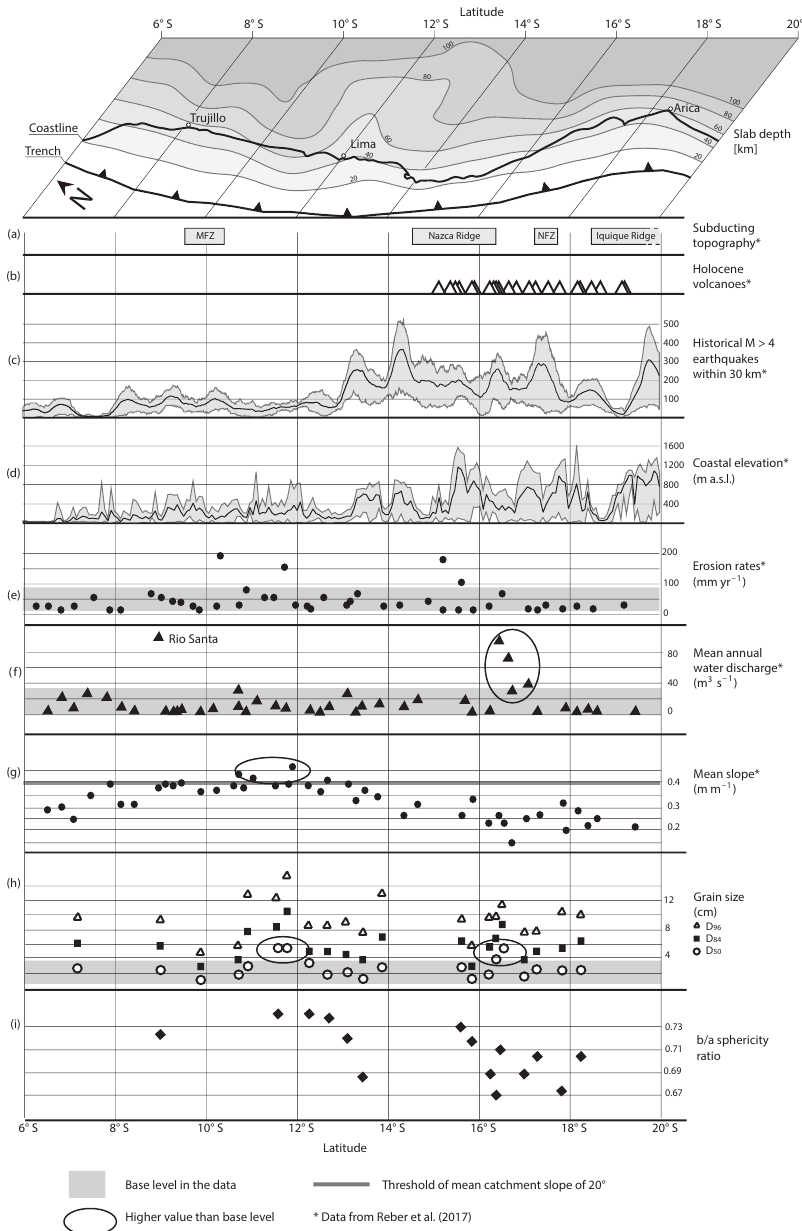
Figure 2. Topography of the subducting Nazca plate, where slab depth data have been extracted from http://earthquake.usgs.gov/data/slab/ modified from Reber et al. (2017). This N–S projection also illustrates (a) tectonic lineaments such as submarine ridges, MFZ: Mendaña frac- ture zone, NFZ: Nazca fracture zone, (b) Holocene volcanoes, (c) earthquake data taken from http://earthquake.usgs.gov/earthquakes/search/ , number of earthquakes with M > 4 within a 30km radius window and (d) coastal elevation. The data have been extracted from a 20km wide swath along the coast. The three lines represent maximum, mean and minimum elevations within the selected swath. (e) Catchment averaged denudation rates have been corrected for quartz contents (Reber et al., 2017). (f) Mean annual precipitation rates (Reber et al., 2017). (g) Mean annual water discharge (Reber et al., 2017). (h) Grain size results for the intermediate b axis of the pebbles in the rivers from north to south at the sampling sites presented in Fig. 1. (i) Ratio between the intermediate axis and the long a axis (modified after Reber et al., 2017). Exceptionally larger D 50 values of 4–6cm were measured for basins situated between 11–12 and 16–17 ◦ S, where hillslope gradients are steeper than 0.4 on average (i.e. 20–22 ◦ ) or where mean annual stream flows exceed the average values of the western Peruvian streams (10–40m 3 s − 1 ) by a factor of